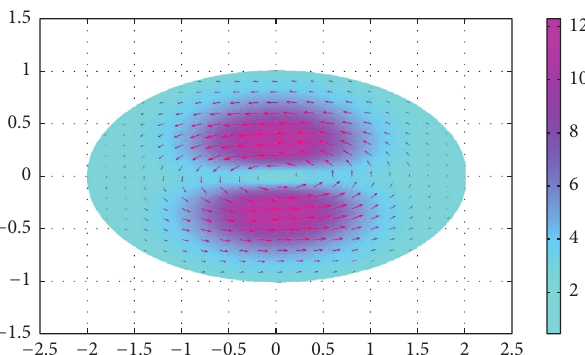
Figure 8: Tangential stress field per unit twist 𝜏 3 /𝛼 ; 𝑎 = 2 , 𝑏 = 1 ; 𝑘 = 𝑘 = 1 , 𝑘 = 2 . Color spectrum: ‖ 𝜏 1 3 2